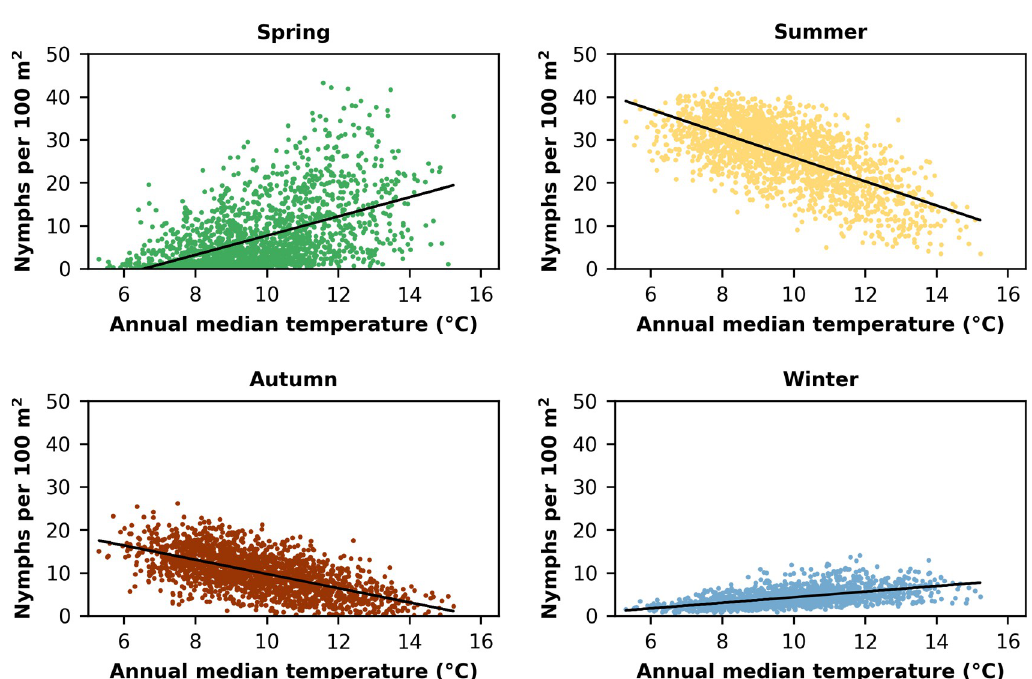
Fig 6. Relationship of the annual median temperature (x-axis) and the density of questing nymphs / 100 m 2 (y-axis) for the seasons of a